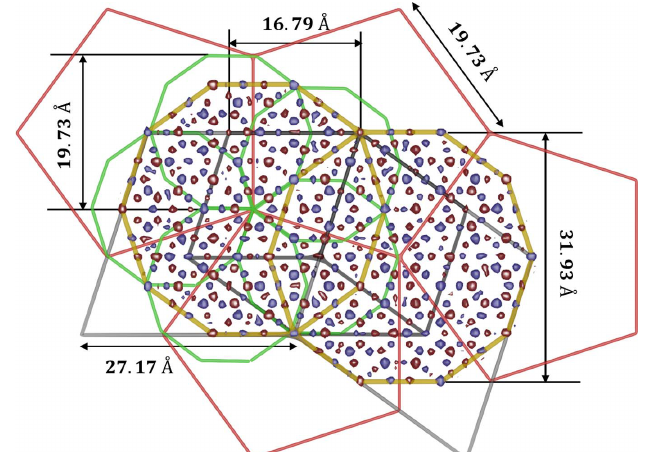
Figure 5 Relations between different tilings and clusters found in decagonite. The atomic decoration of the basic building blocks of the structure, the thick and thin rhombi of the 16.79 A˚ RPT, are found based on the relation to the Hiraga